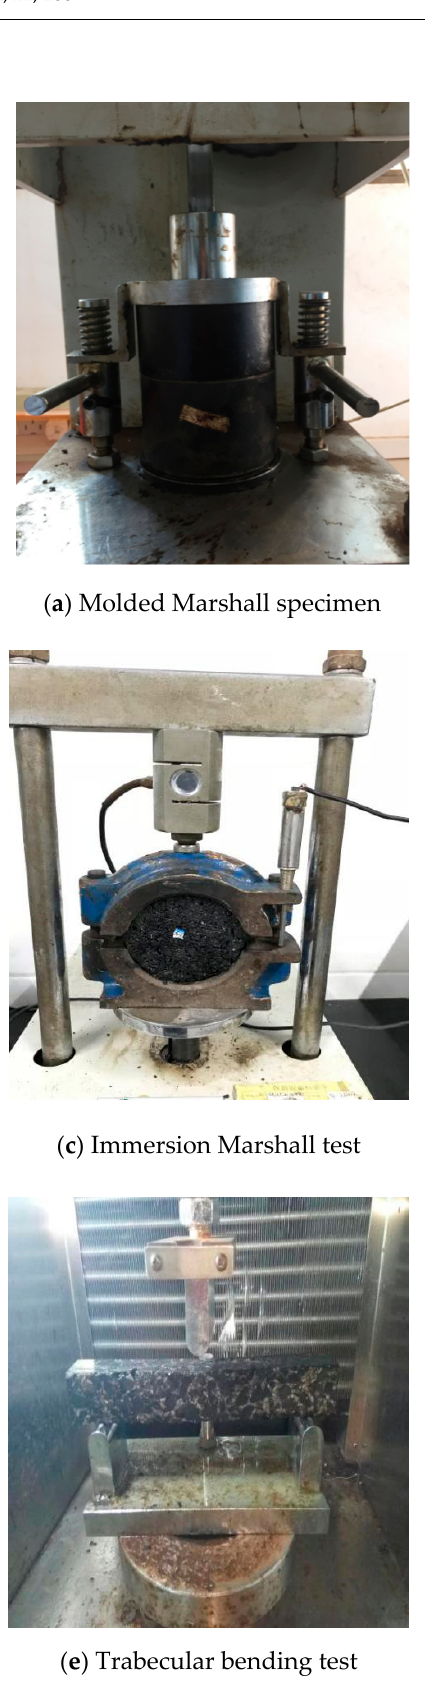
Figure 2. Setup for each test.